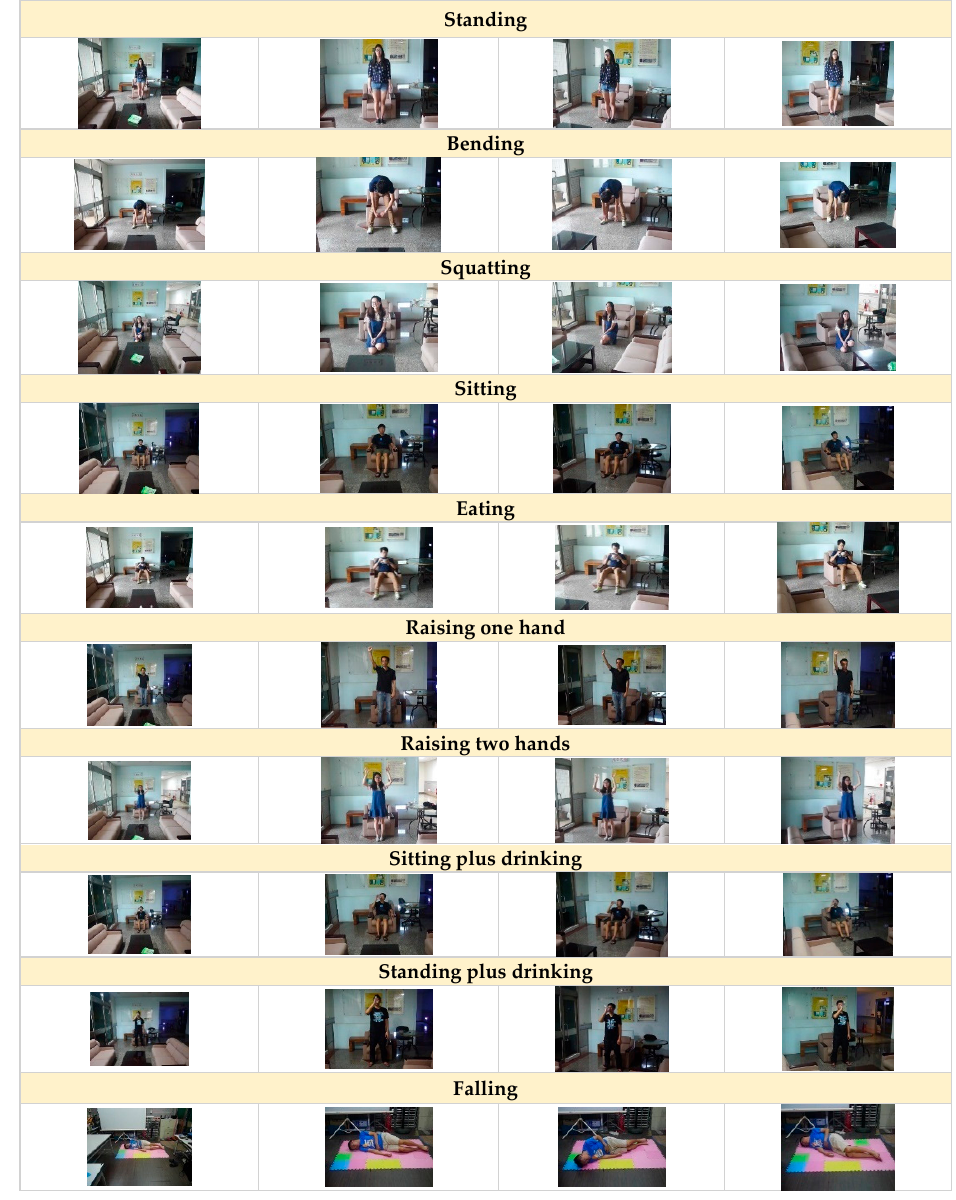
Figure 1. Ten most common